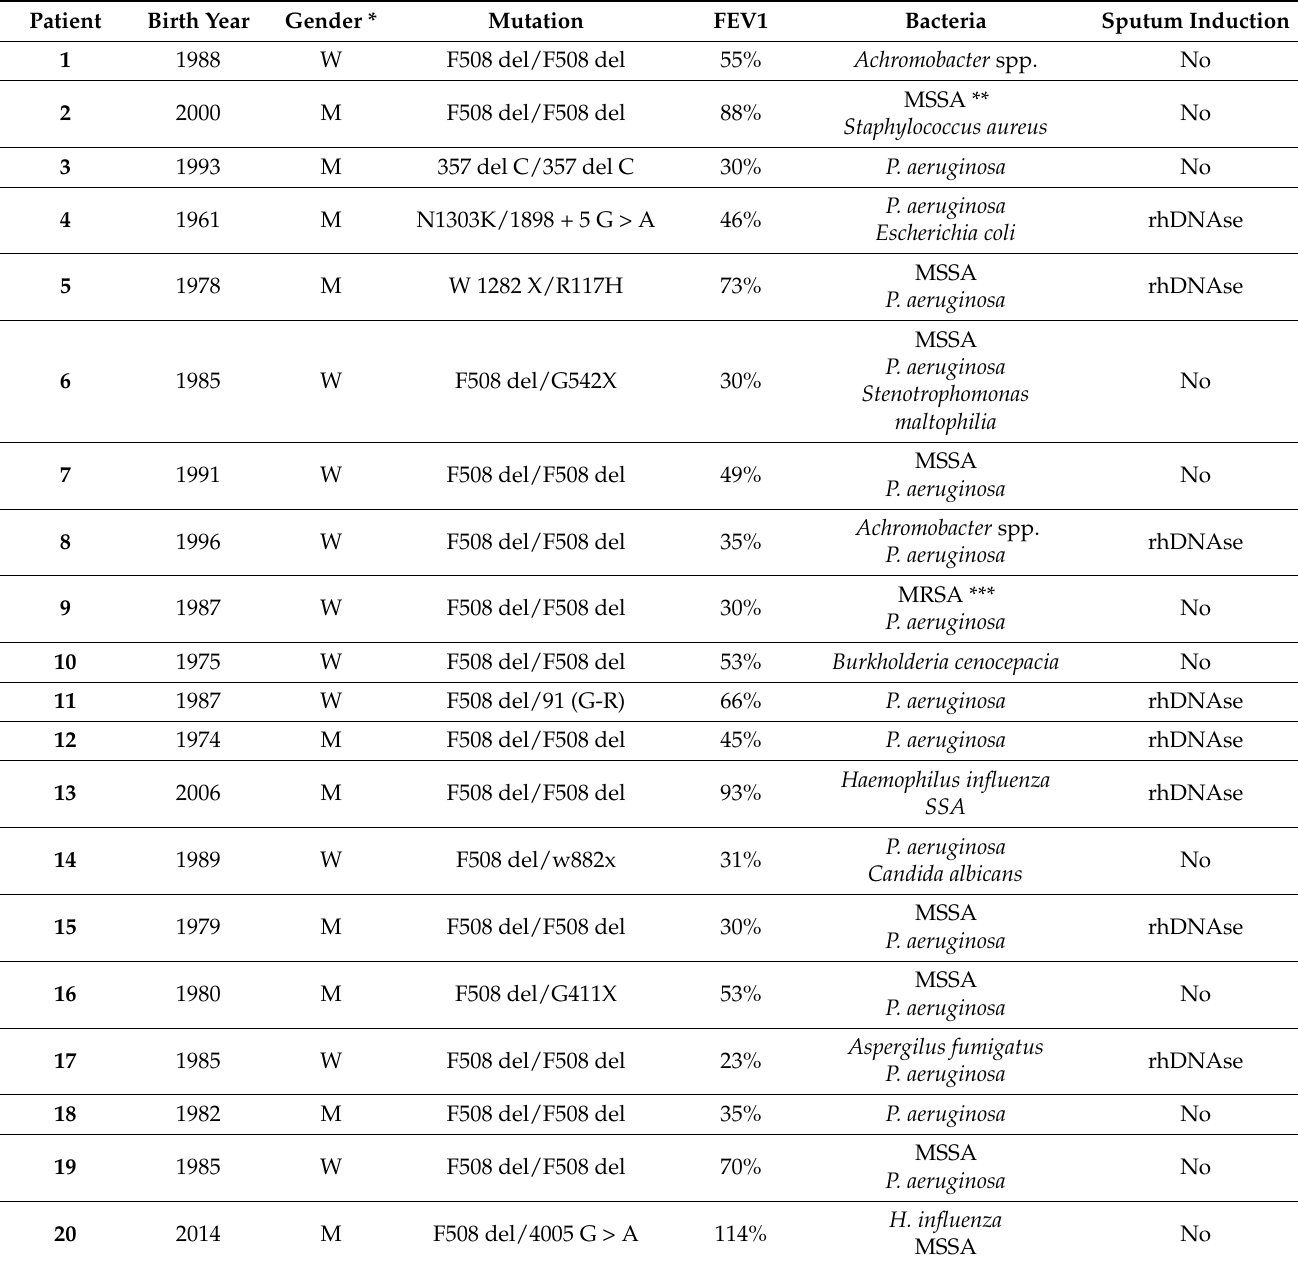
Table 1. Clinical data of CF patients at the time of sputum